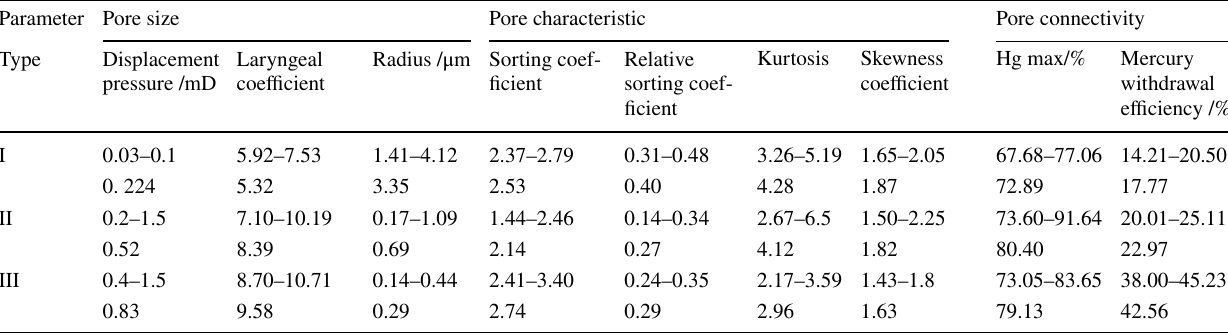
Table 1 Classification of pore parameter Parameter Pore